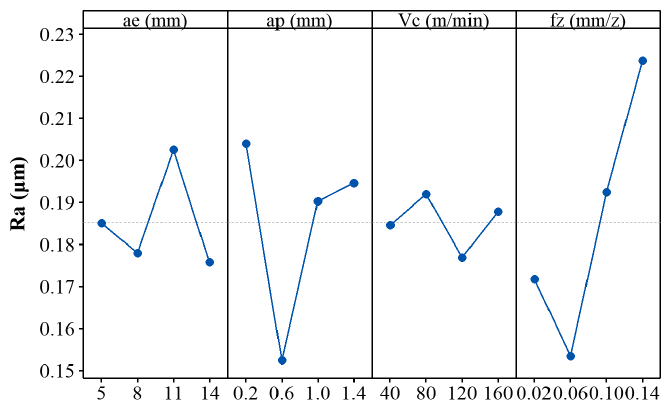
Figure 10. Plot of means for the machined surface roughness R a .